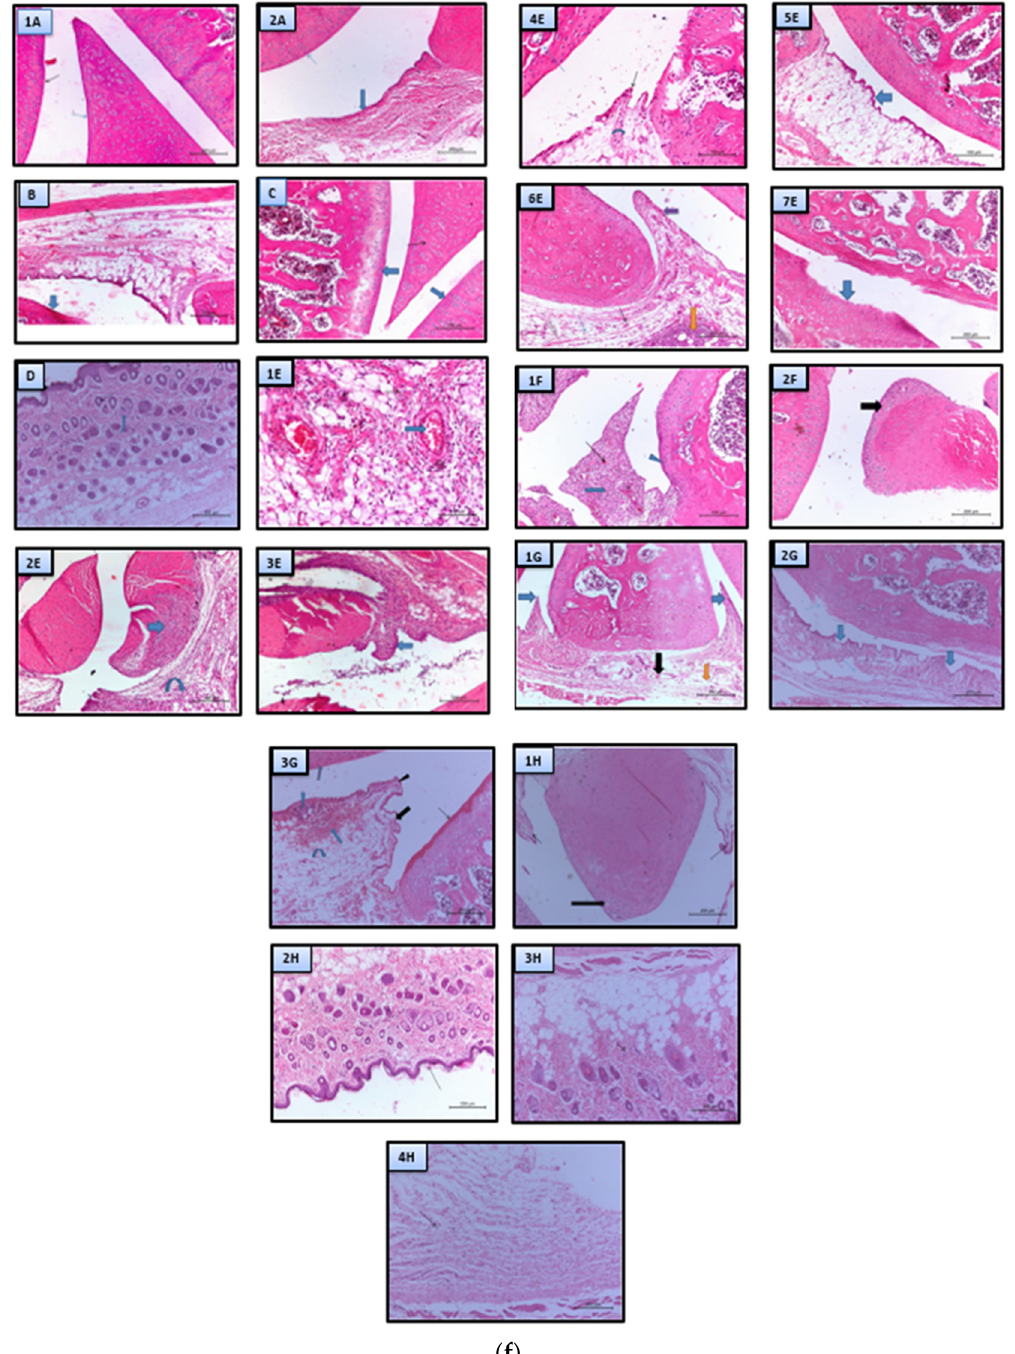
Figure 4. ( a ) Effect of MTX, MTX-Nano solution, and MTX-Nano gel on Anti-CCP in CFA induced rheumatoid arthritis; ( b ) effect of MTX, MTX-Nano solution, and MTX-Nano gel on IL6 in CFA induced rheumatoid arthritis; ( c ) effect of MTX, MTX-Nano solution, and MTX-Nano gel on IL-10 in CFA induced rheumatoid arthritis; ( d ) effect of MTX, MTX-Nano solution, and MTX-Nano gel on RANKL in CFA induced rheumatoid arthritis; ( e ) effect of MTX, MTX-Nano solution, and MTX-Nano gel on COMP in CFA induced rheumatoid arthritis; ( f ) histopathologic examinations under a light microscope on knee joints by H&E staining (magnification × 200 and × 100). The effects of MTX, MTX-Nano solution, and MTX-Nano gel on histopathological changes were measured. Histopathologic examinations under a light microscope on